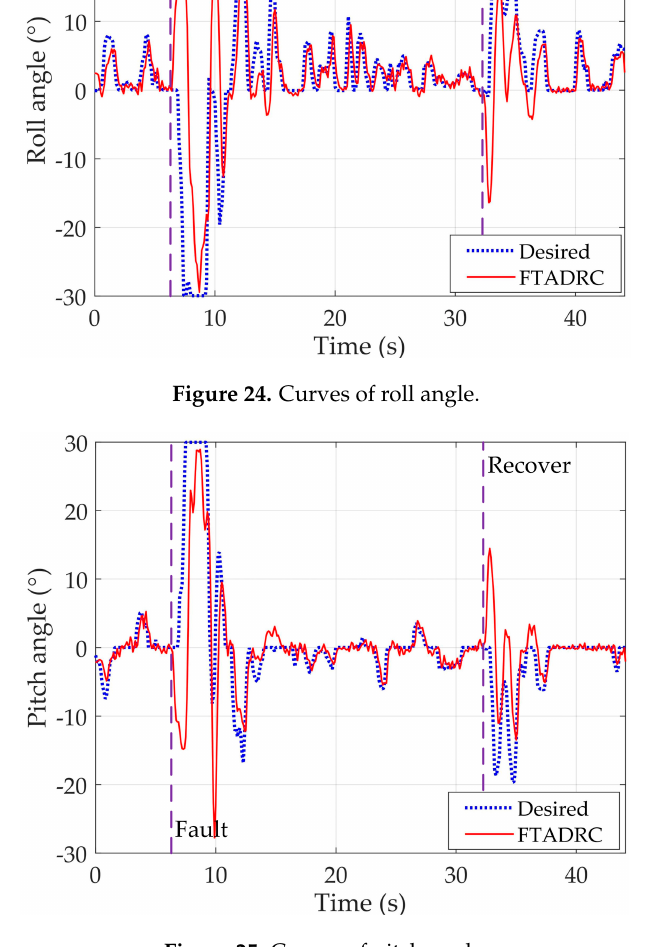
Figure 25. Curves of pitch angle.